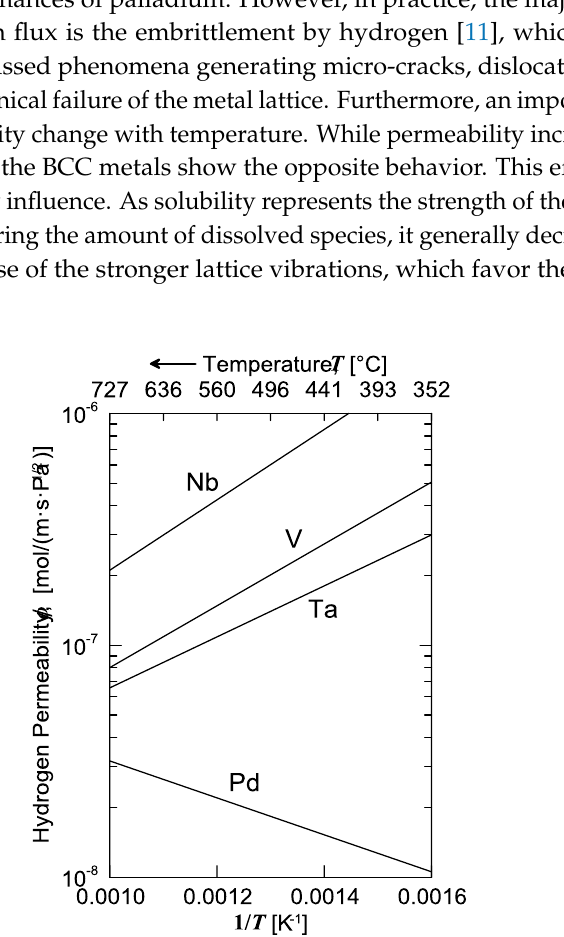
Figure 10. Permeability of selected metals as a function of temperature. Adapted from Buxbaum and Kinney [32].